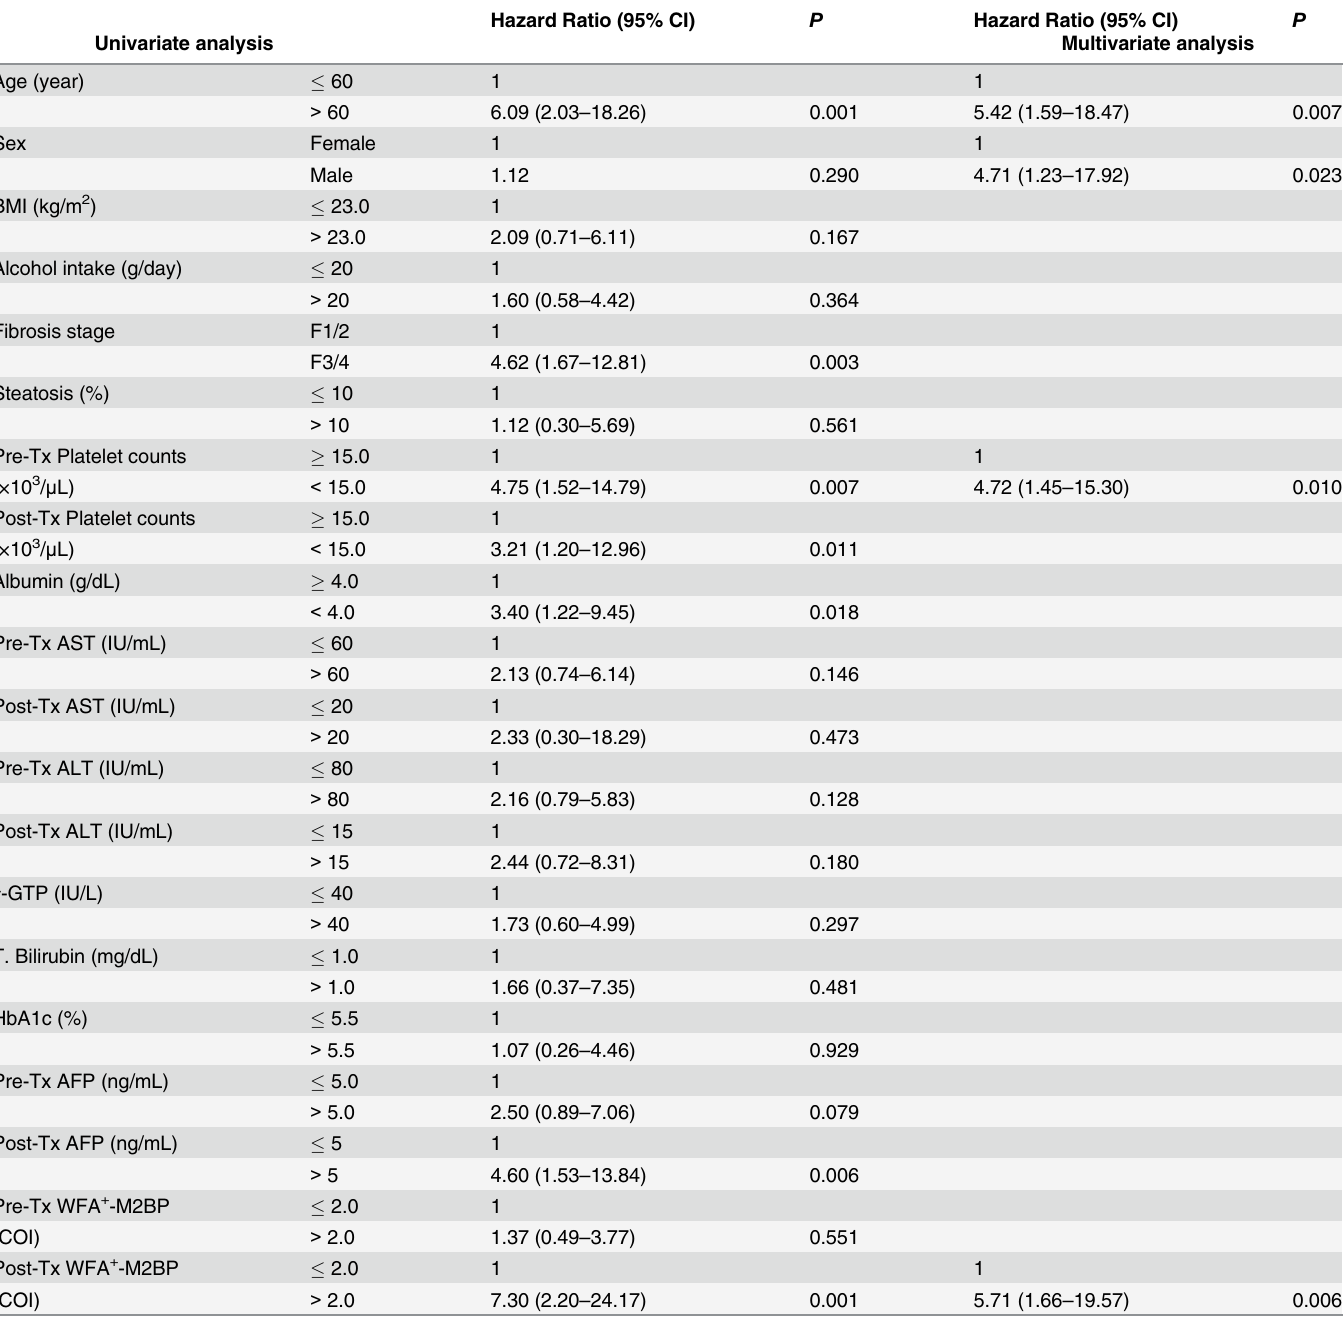
Table 2. Factors Associated with Hepatocellular Carcinoma.